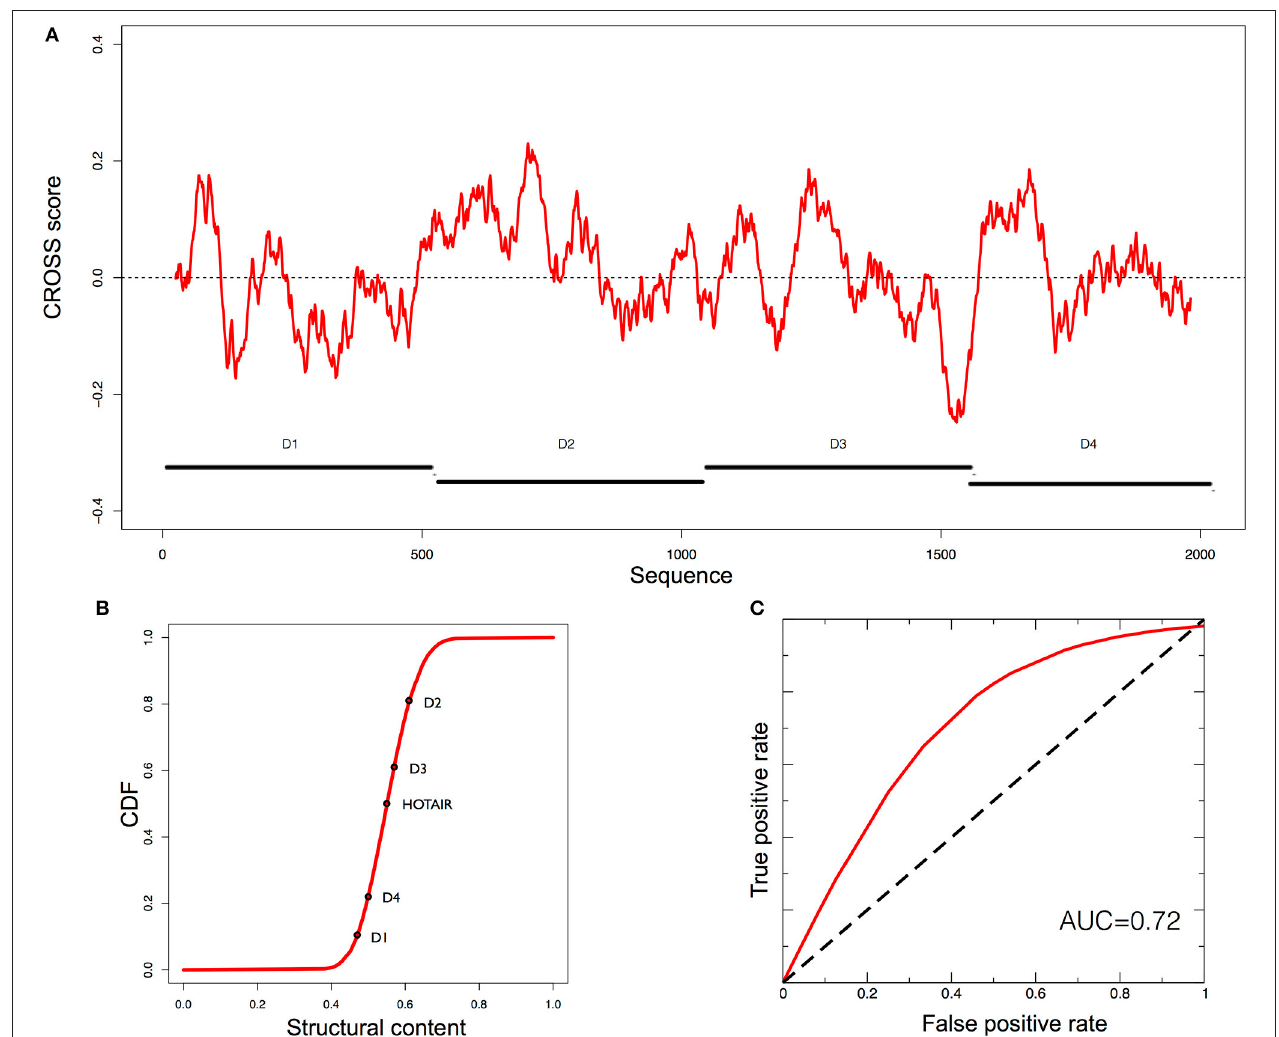
FIGURE 5 | Predictions of HOTAIR structure. (A) Secondary structure profile of the complete murine HOTAIR obtained using CROSS. Positive regions are to be considered double-stranded, negative regions single-stranded. (B) Cumulative distribution function (CDF) for the structural content of all the human lincRNAs predicted by CROSS. The structural contents of the D domains of HOTAIR are reported on the curve. (C) ROC curve of CROSSalign to identify reverse engineered sequences with the same structure as D2 and a different